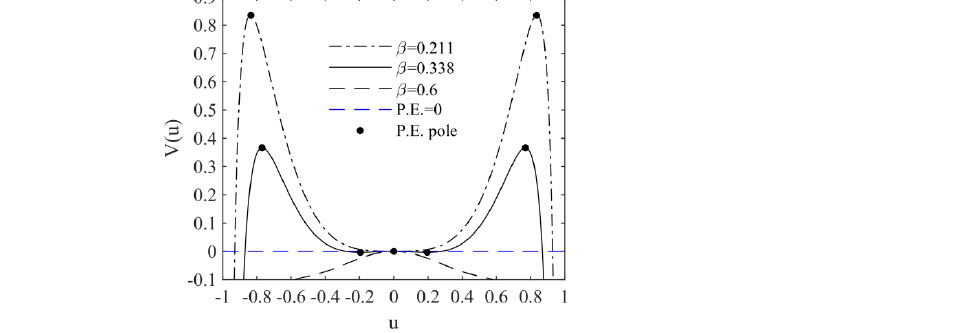
Figure 2. Potential energy of the unperturbed system (4) under different values of parameter β .